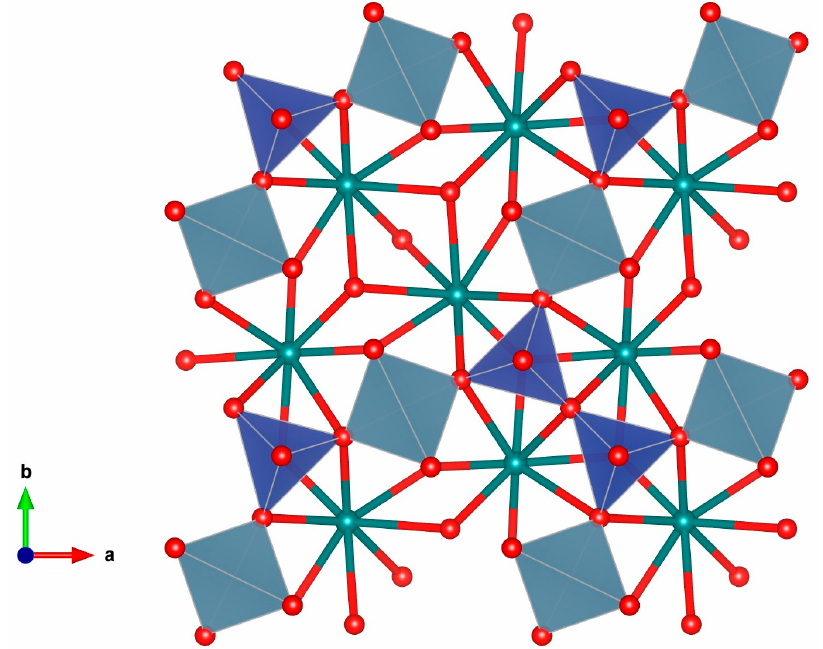
Figure 5. Projection of the structure of gehlenite (sample CE 4 b) along (001). The deep blue tetrahedrons represent SiO 4 , the gray blue octahedrons represent AlO 4 , the red circles represent O atoms, and the turquoise circles represent the eight-for coordinated Ca atoms.